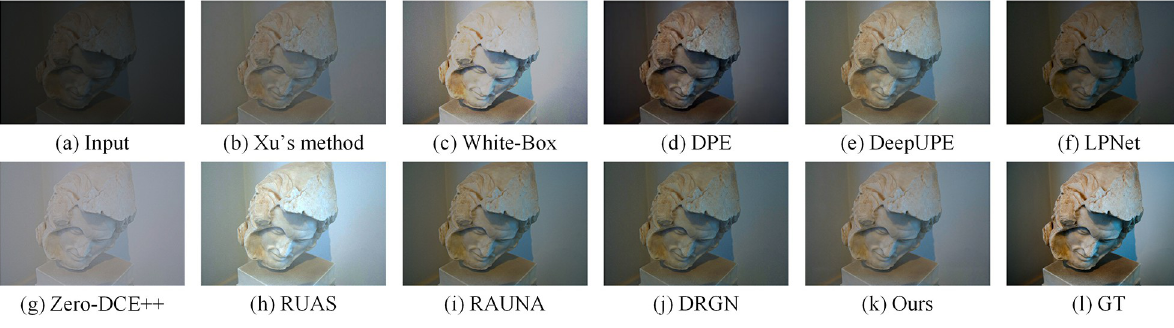
Fig 7. Visual results of different methods on MIT5K dataset for image number 4501. (a) Input. (b) Xu’s method. (c) White-Box. (d) DPE. (e) DeepUPE. (f) LPNet. (g) Zero-DCE++. (h) RUAS. (i) RAUNA. (j) DRGN. (k) Ours. (l) GT.